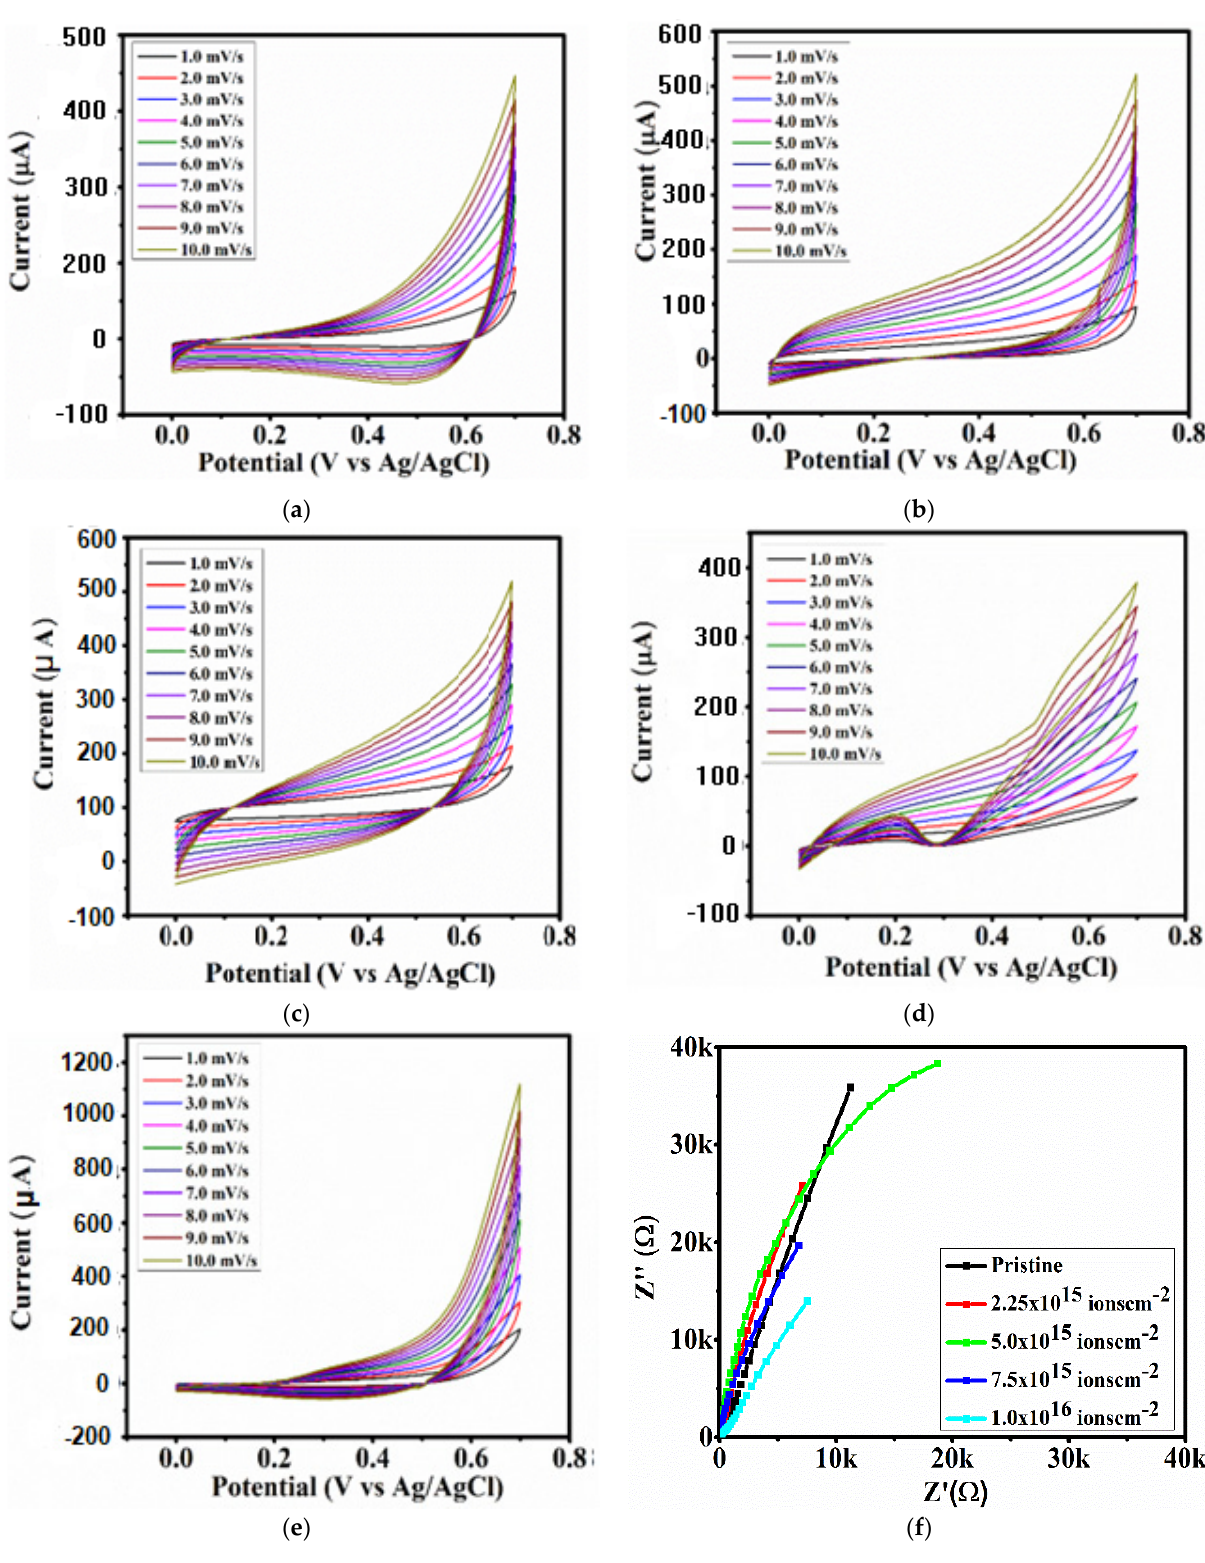
Figure 7. CV of Co 3 O 4 @MnO 2 @NiO/GO Electrodes for ( a ) pristine samples radiated with ( b ) 2.5 × 10 15 , ( c ) 5.0 × 10 15 , ( d ) 7.5 × 10 15 , ( e ) 1.0 × 10 15 ions/cm 2 energy and ( f ) EIS. The GCD plots of Co 3 O 4 @MnO 2 @NiO/GO electrodes shown in Figure 8a,b for current densities of 1.0 and 2.0 A/g disclose non-linear inclined voltage vs time variations [70].